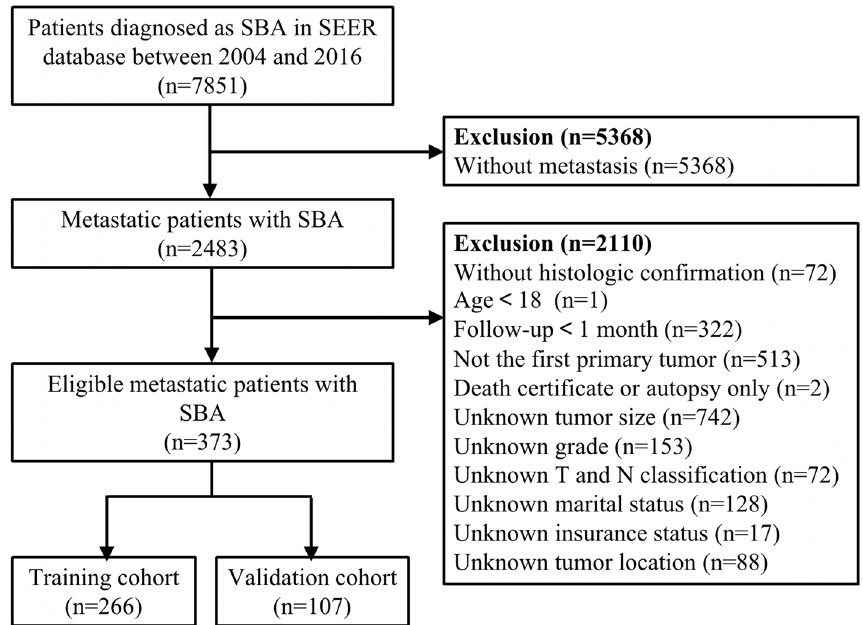
Figure 1. Flow diagram of eligible metastatic patients diagnosed with small bowel adenocarcinoma